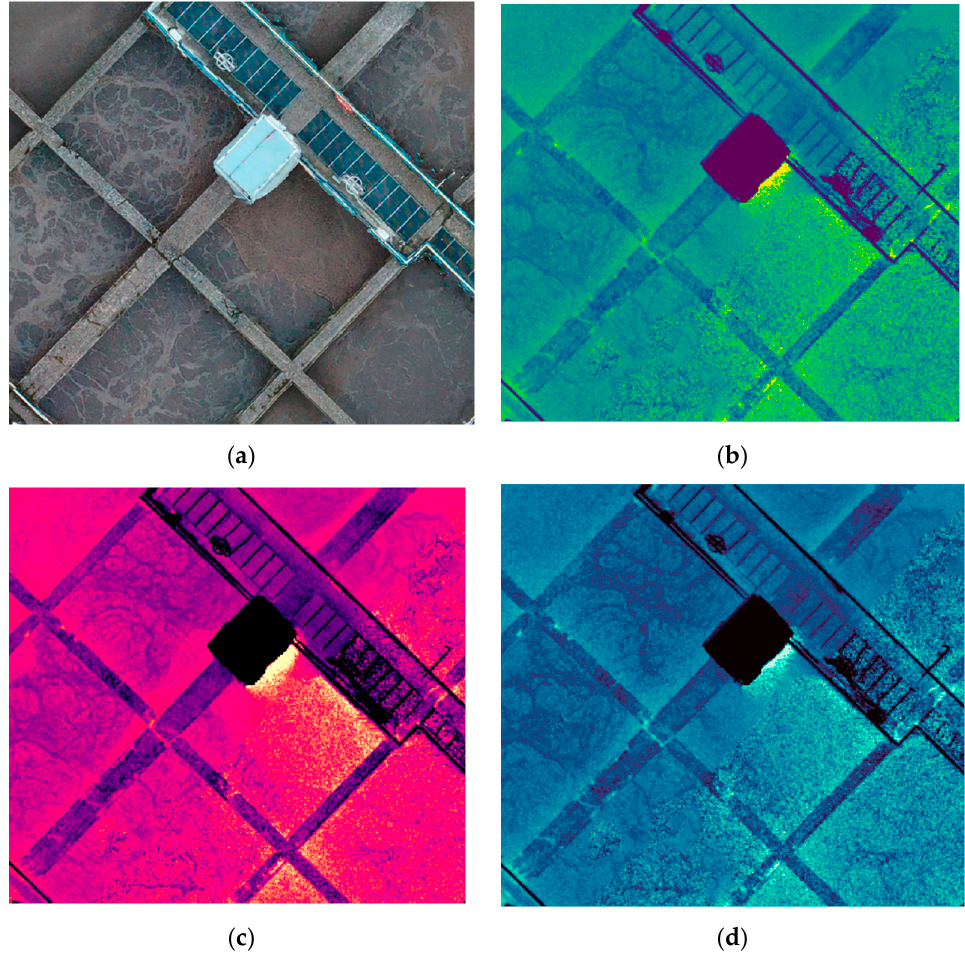
Figure 4. Location of detected anomalies inside the CNs of the bioreactor on a map base: ( a ) high- resolution orthophoto, ( b ) NDVI, ( c ) OSAVI, and ( d ) GNDVI. resolution orthophoto, ( b ) NDVI, ( c ) OSAVI, and ( d )